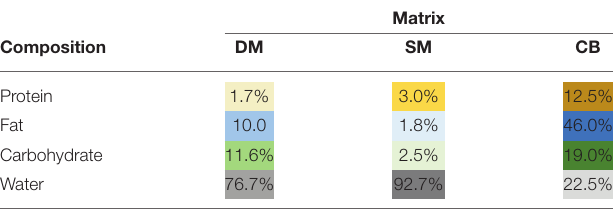
TABLE 1 | Composition of food